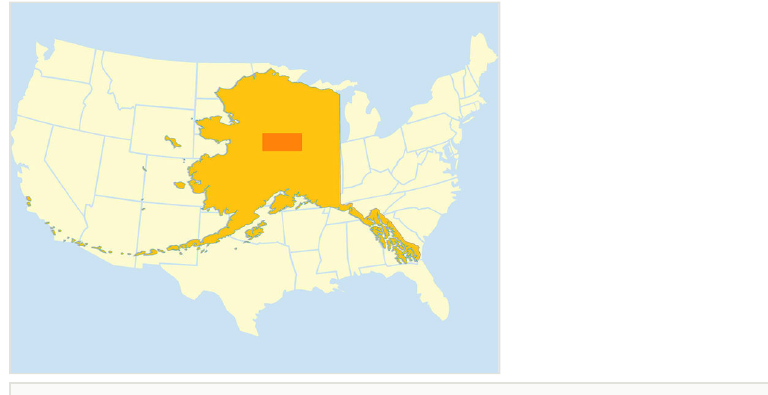
Figure 1. Map showing study region (dark orange rectangle) of Interior Alaska, centred around the city of Fairbanks, superimposed on map of the contiguous US states for scale. Original map by Laubenstein Ronald, U.S. Fish and Wildlife Service, is in the public domain.